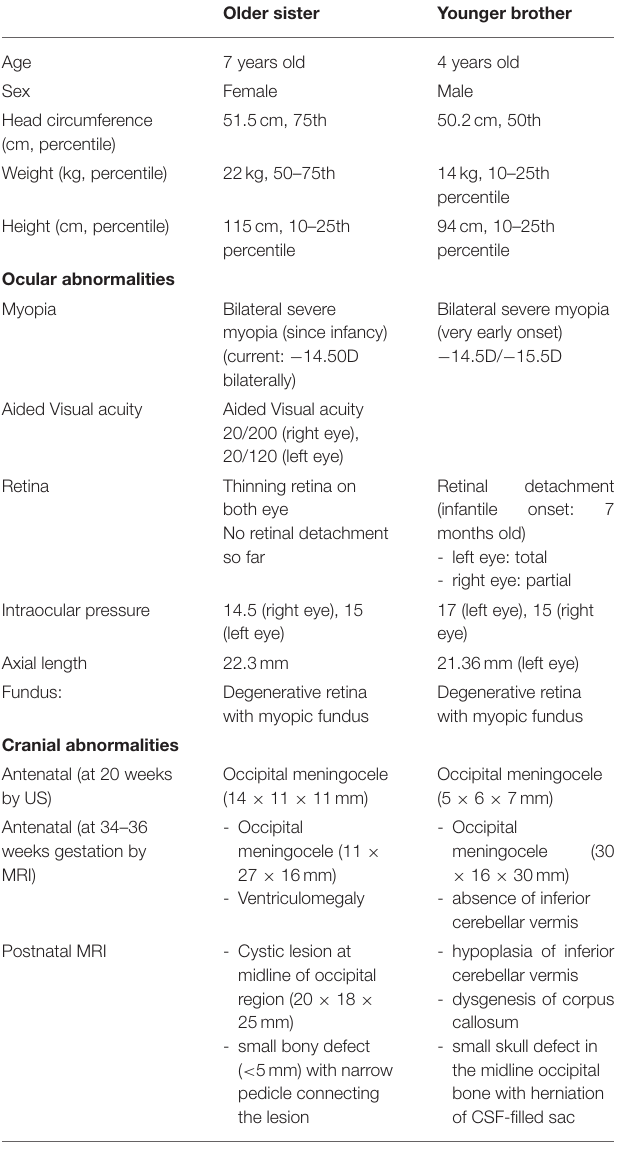
TABLE 1 | The core clinical features and comparison of these two